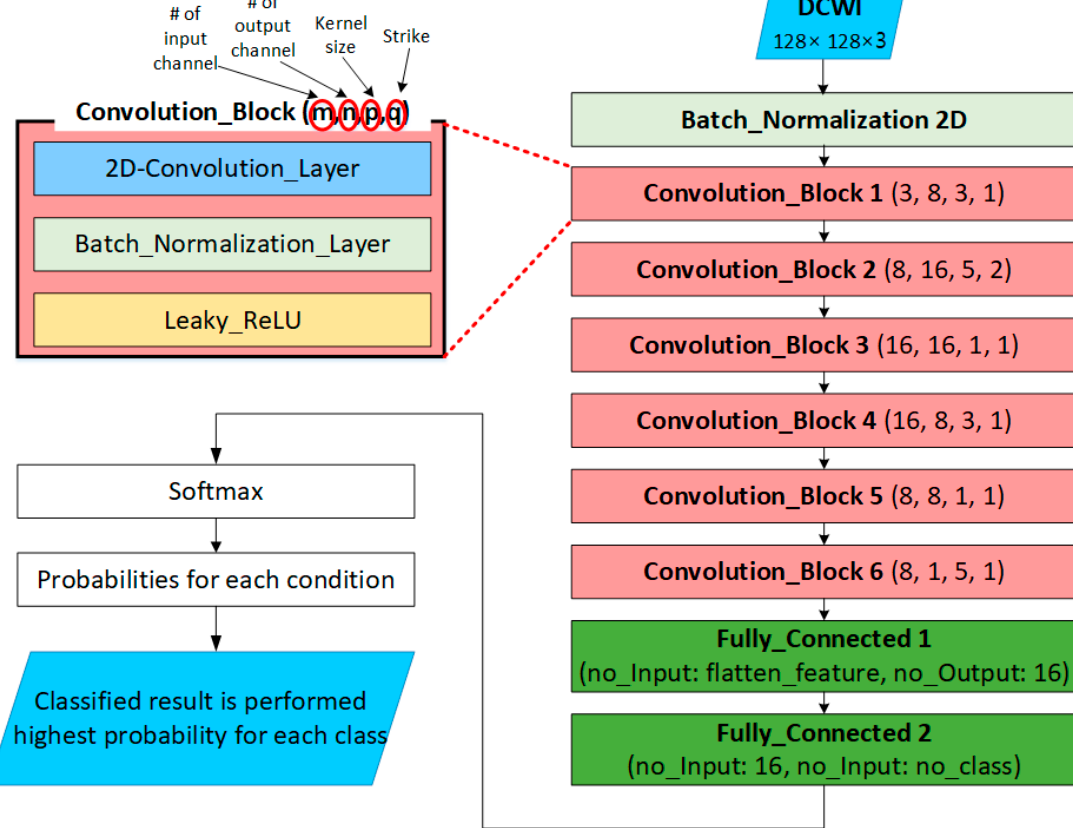
Figure 5. The proposed deep convolution neural network architecture diagram for the 128 × 128 size images.